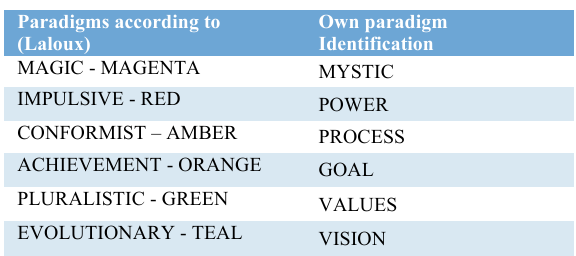
Table 1. Translation of original paradigms to own